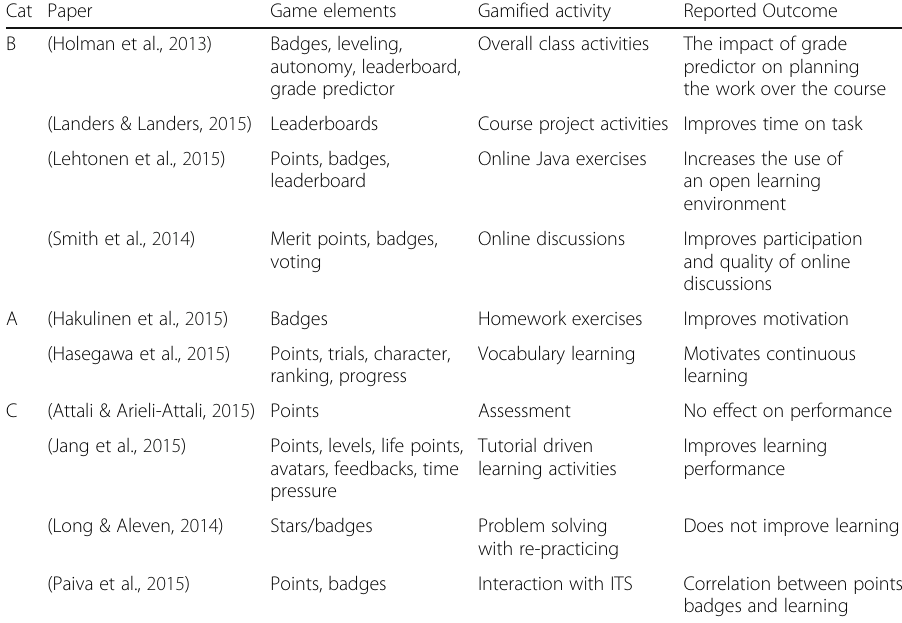
Table 10 Categorization of studies falling into a single category: Behavioral (B), Affective (A) or Cognitive